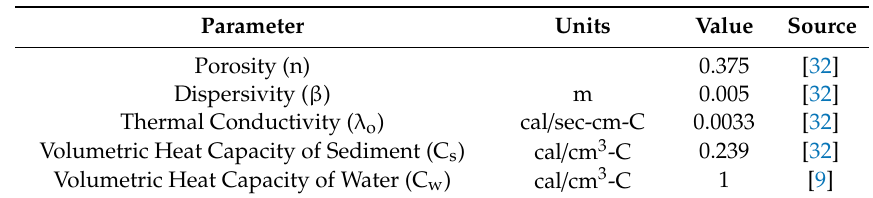
Table 1. Parameter values used in flux calculations. The parameters representative of the Henry